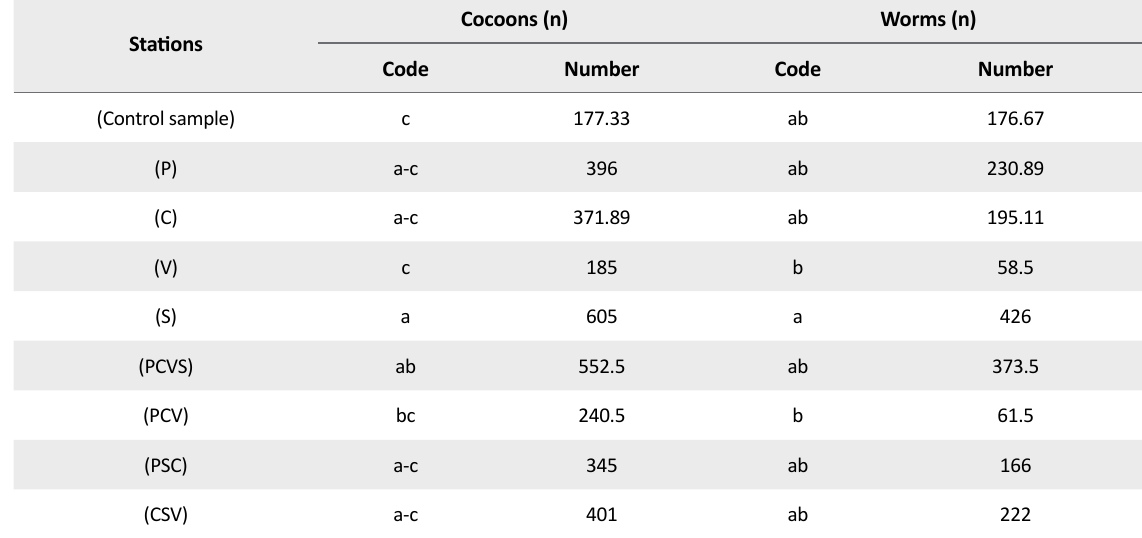
Table 3. Comparing the mean number of cocoons and earthworms in the production of vermicompost from various organic wastes